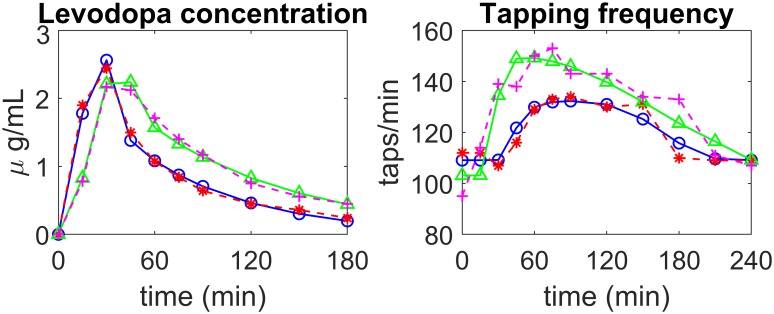
Examples of model fitting to real data in two patients of the second group (fluctuating).The left panels show LD concentration in plasma, the right panels the finger tapping rate. Patient 2—experimental data: dashed red lines with asterisks; simulation results: continuous blue lines with open circles; Patient 12—experimental data: magenta dashed lines with crosses; simulation results: continuous green lines with triangles.